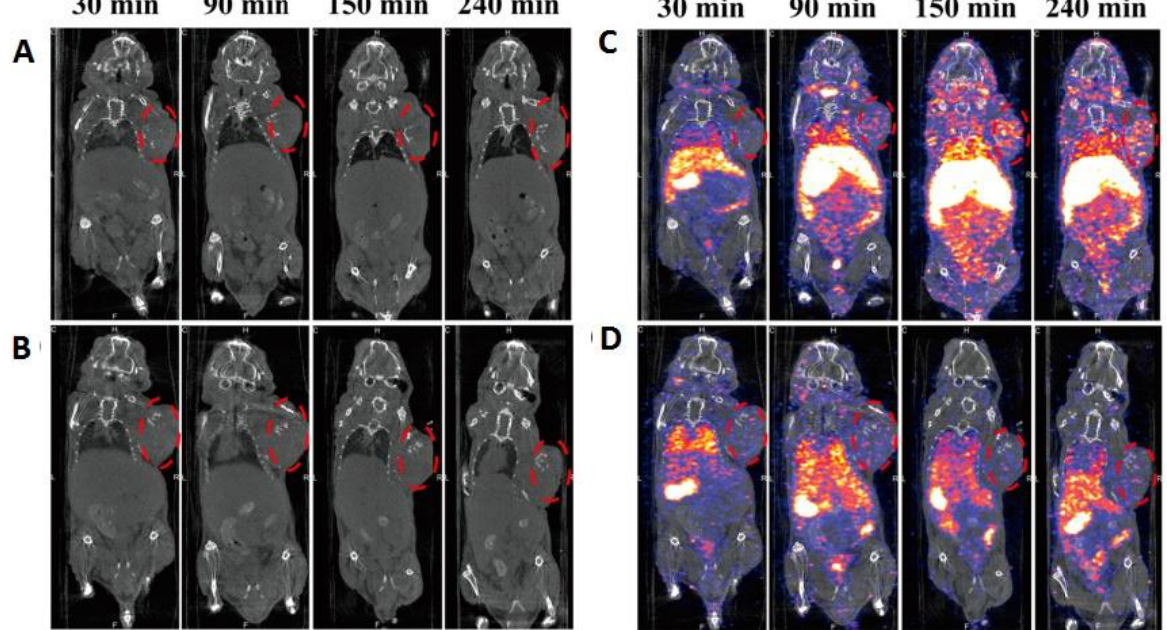
Figure 5. ( A , B ) In vivo CT and ( C , D ) SPECT/CT images of a xenografted tumor model after intravenous injection of {(Au 0 ) 6 -G2-DTPA ( 99m Tc)-PEG-FA} DENPs ( A , C , respectively) and ({(Au 0 ) 6 -G2-DTPA ( 99m Tc)-mPEG} DENPs) ( B , D , respectively). High uptake in the liver, spleen, and tumor is visible. Reprinted with permission from [40], with permission from American Chemical Society, 2016.